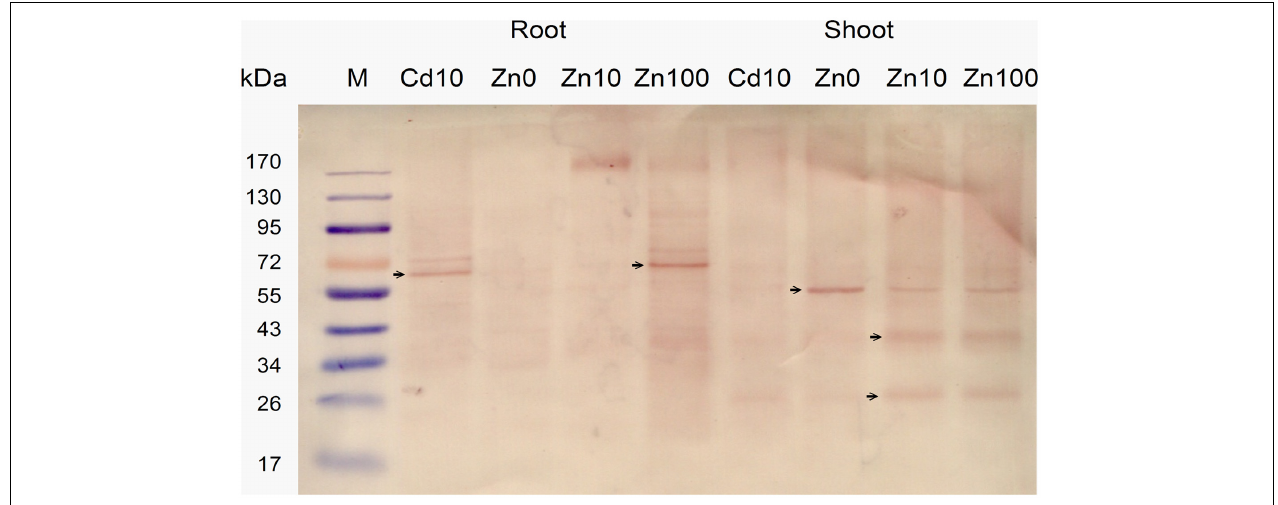
FIGURE 3 | Analysis of NcHMA4 expression through Western blot with NcHMA4-specific primary antibody (Parameswaran et al., 2007) and Anti-rabbit IgG secondary antibody. Each lane corresponds to approximately 20 mg of fresh plant tissue from which the proteins were extracted. Three independent replicate plants experiments were carried out, a typical blot is